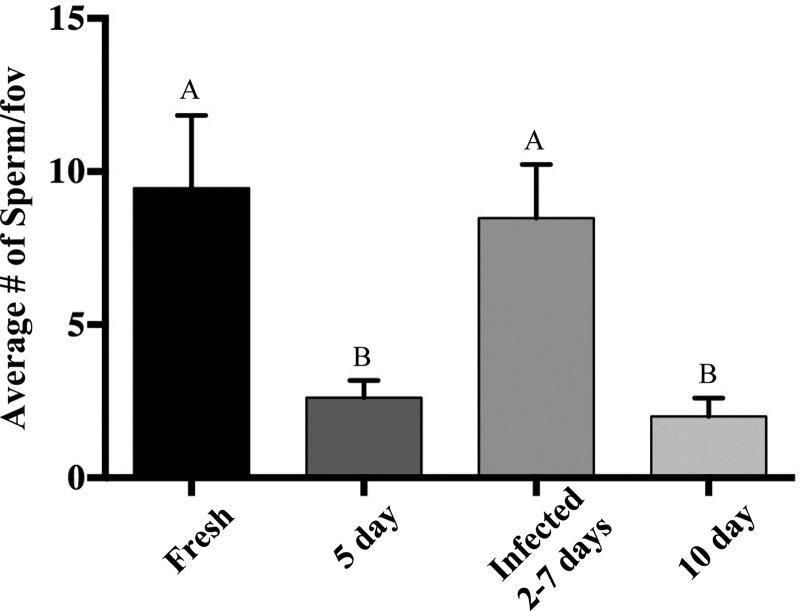
Detection of perivitelline membrane-bound sperm by Hoechst 33342 staining in artificially infected chicken eggs incubated until large microbial plaque formation (2–7 days). Letters denote significant difference (P < 0.05) in number of sperm between infected and fresh, 5 and 10 day incubated eggs.